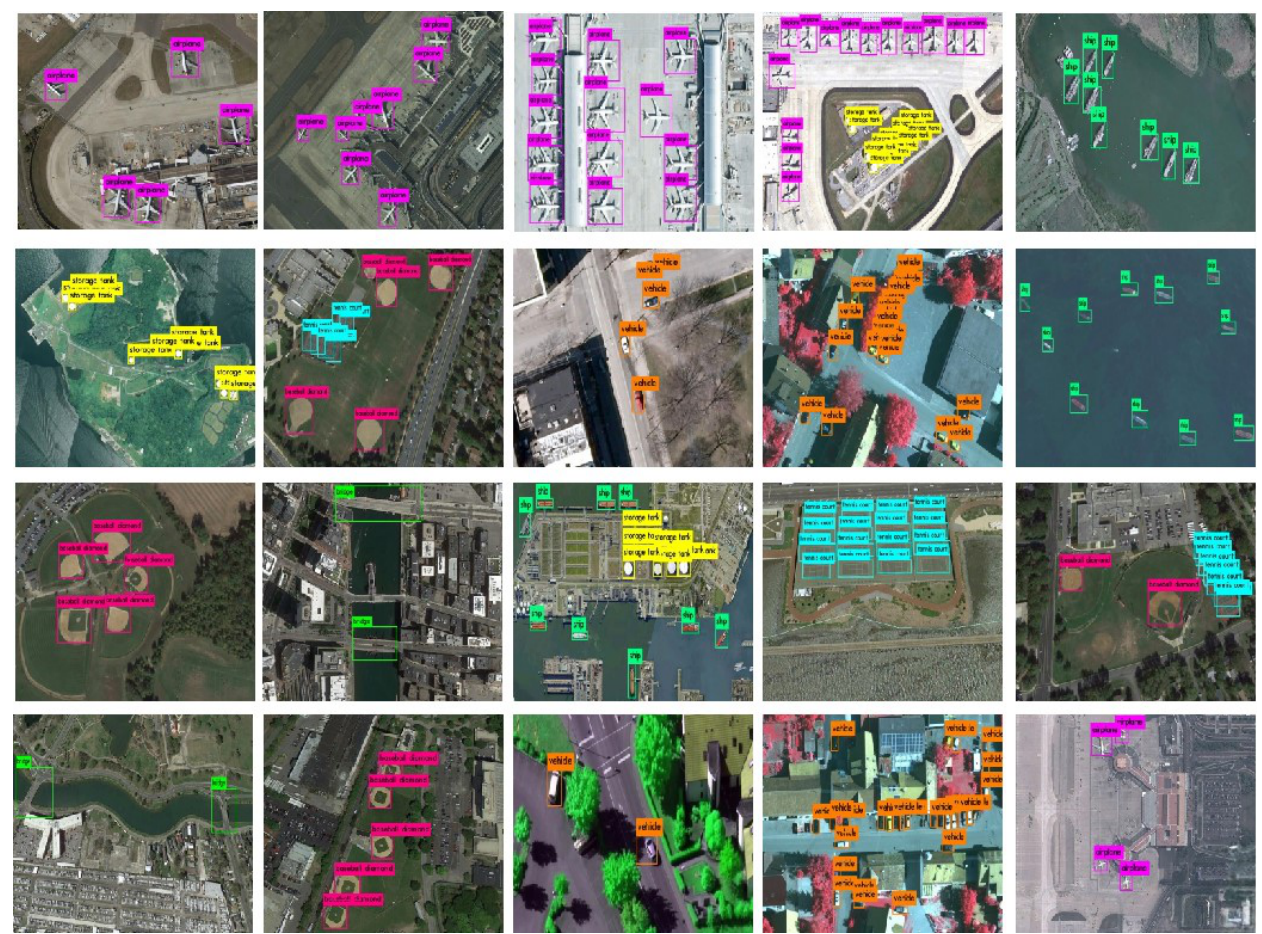
Figure 7. Visual detection results of FESSD on the SD-RSI